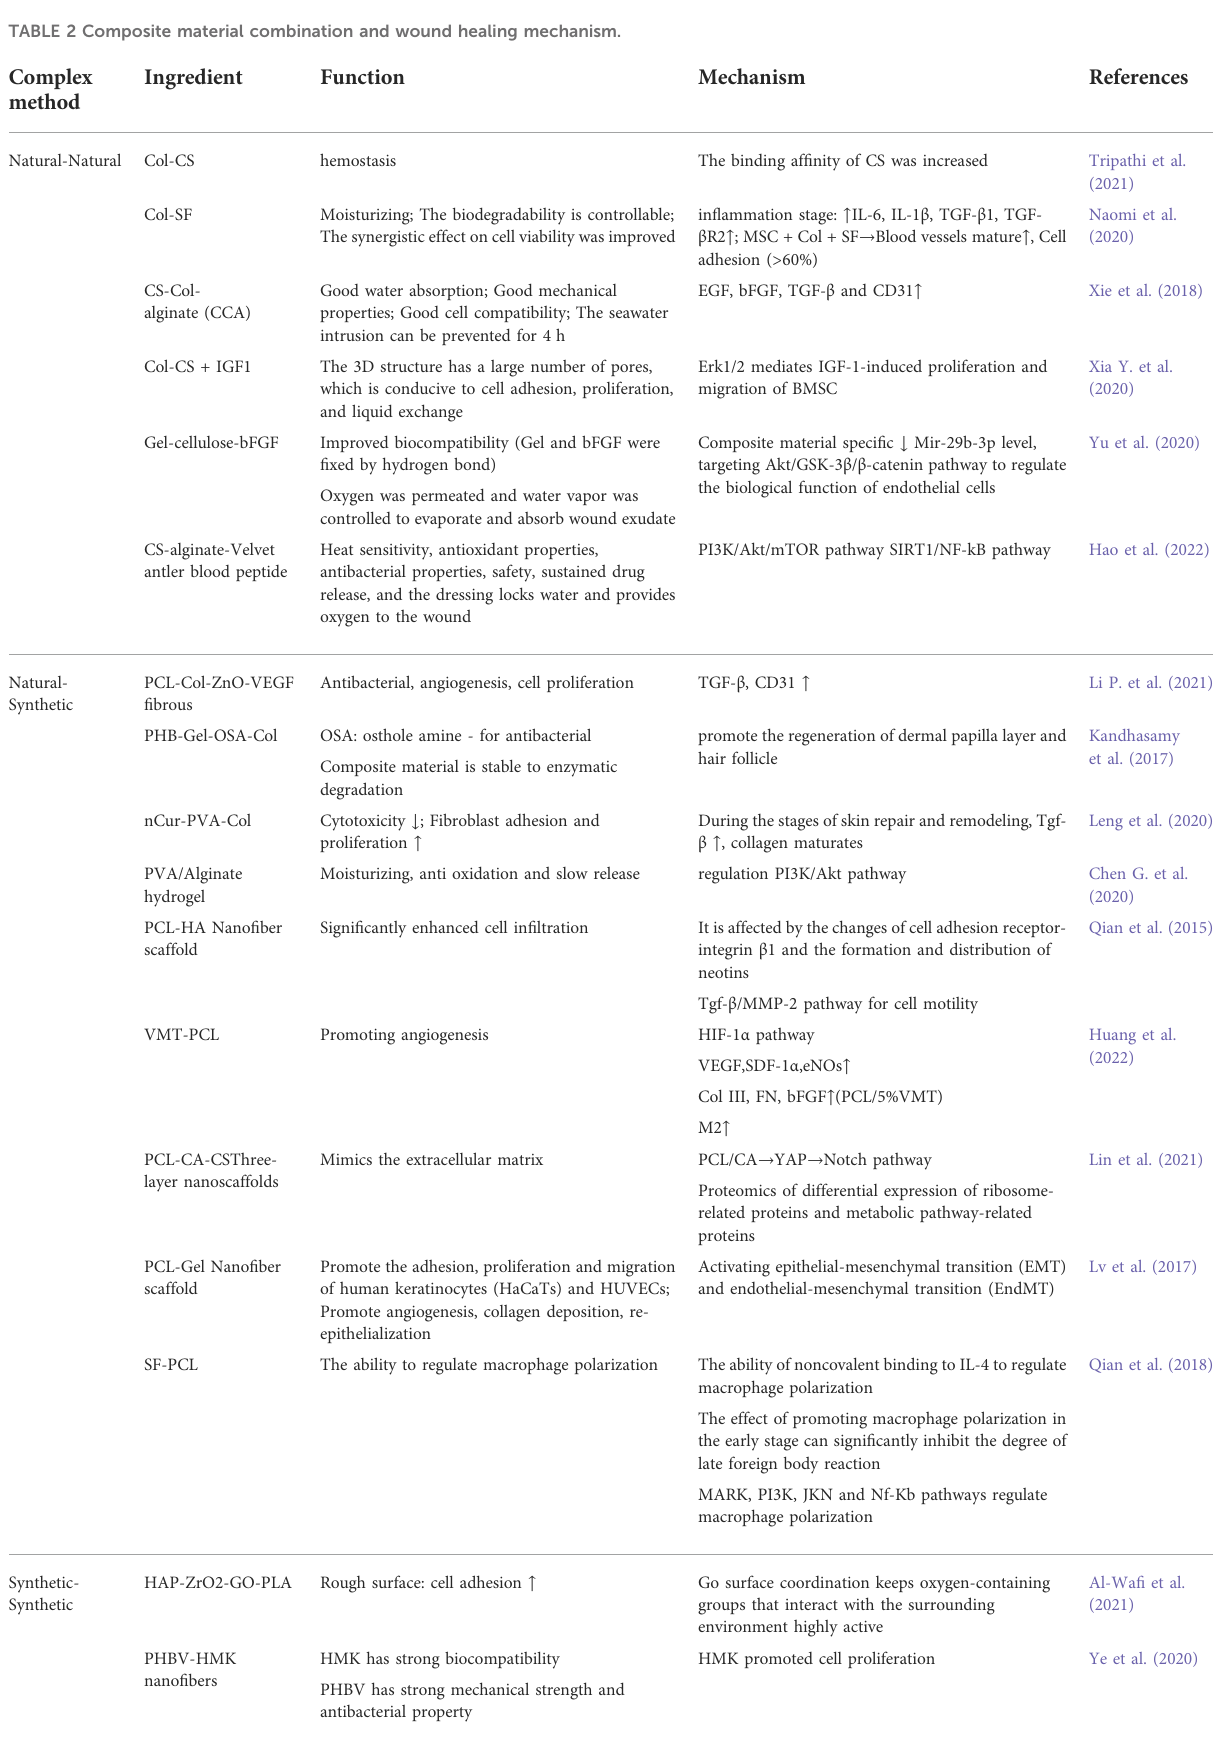
TABLE 2 Composite material combination and wound healing